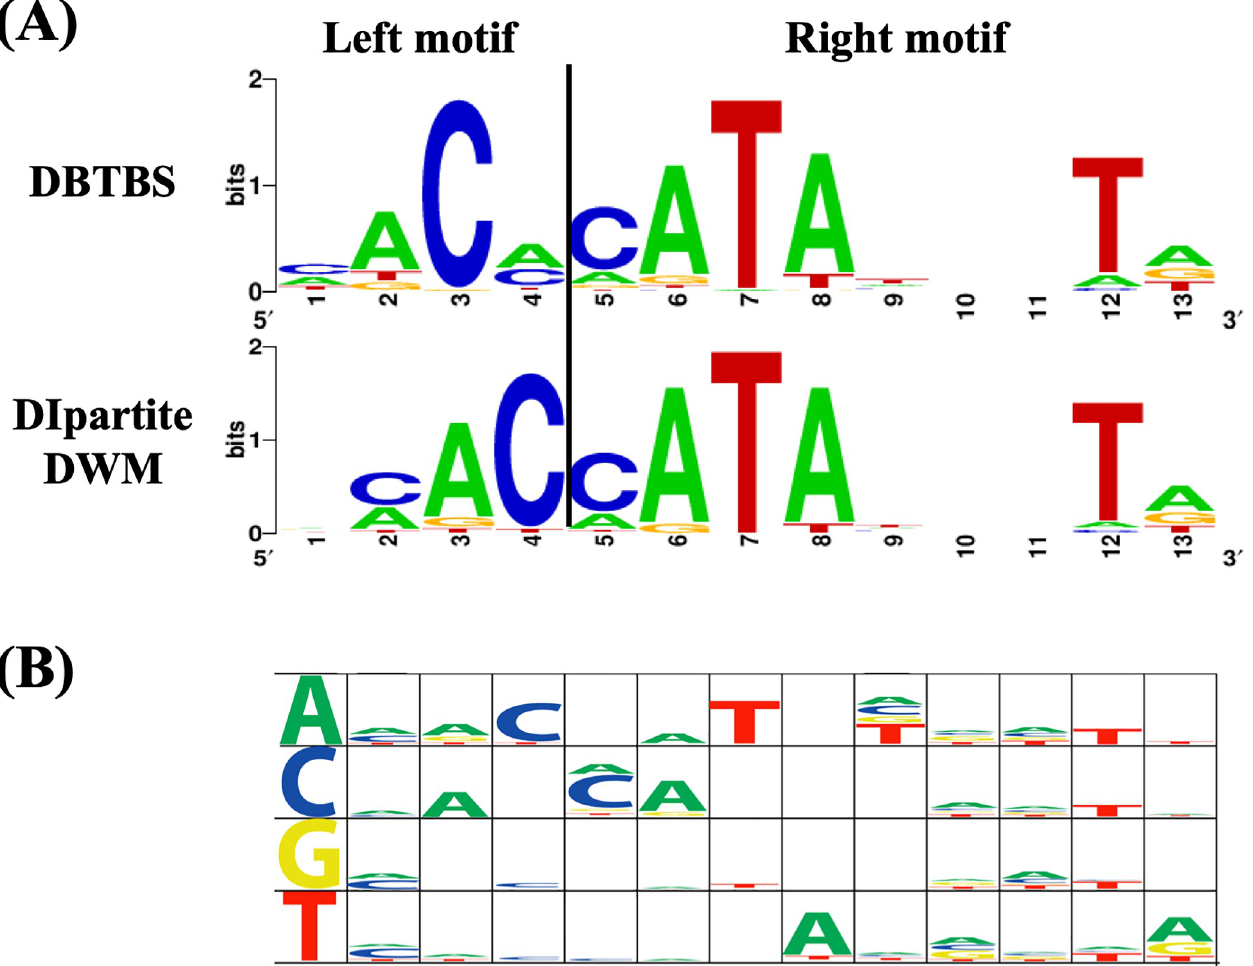
Fig 5. Sequence logo for σ K by DIpartite DWM. (A) Sequence logos generated by DBTBS and DIpartite DWM. The border between the left and right motifs, i.e., position 4, 5, is indicated as the vertical line. (B) Sequence logo for the probability of each dinucleotides. One base before was depicted in first column. Size of each logo was proportional to the probability of